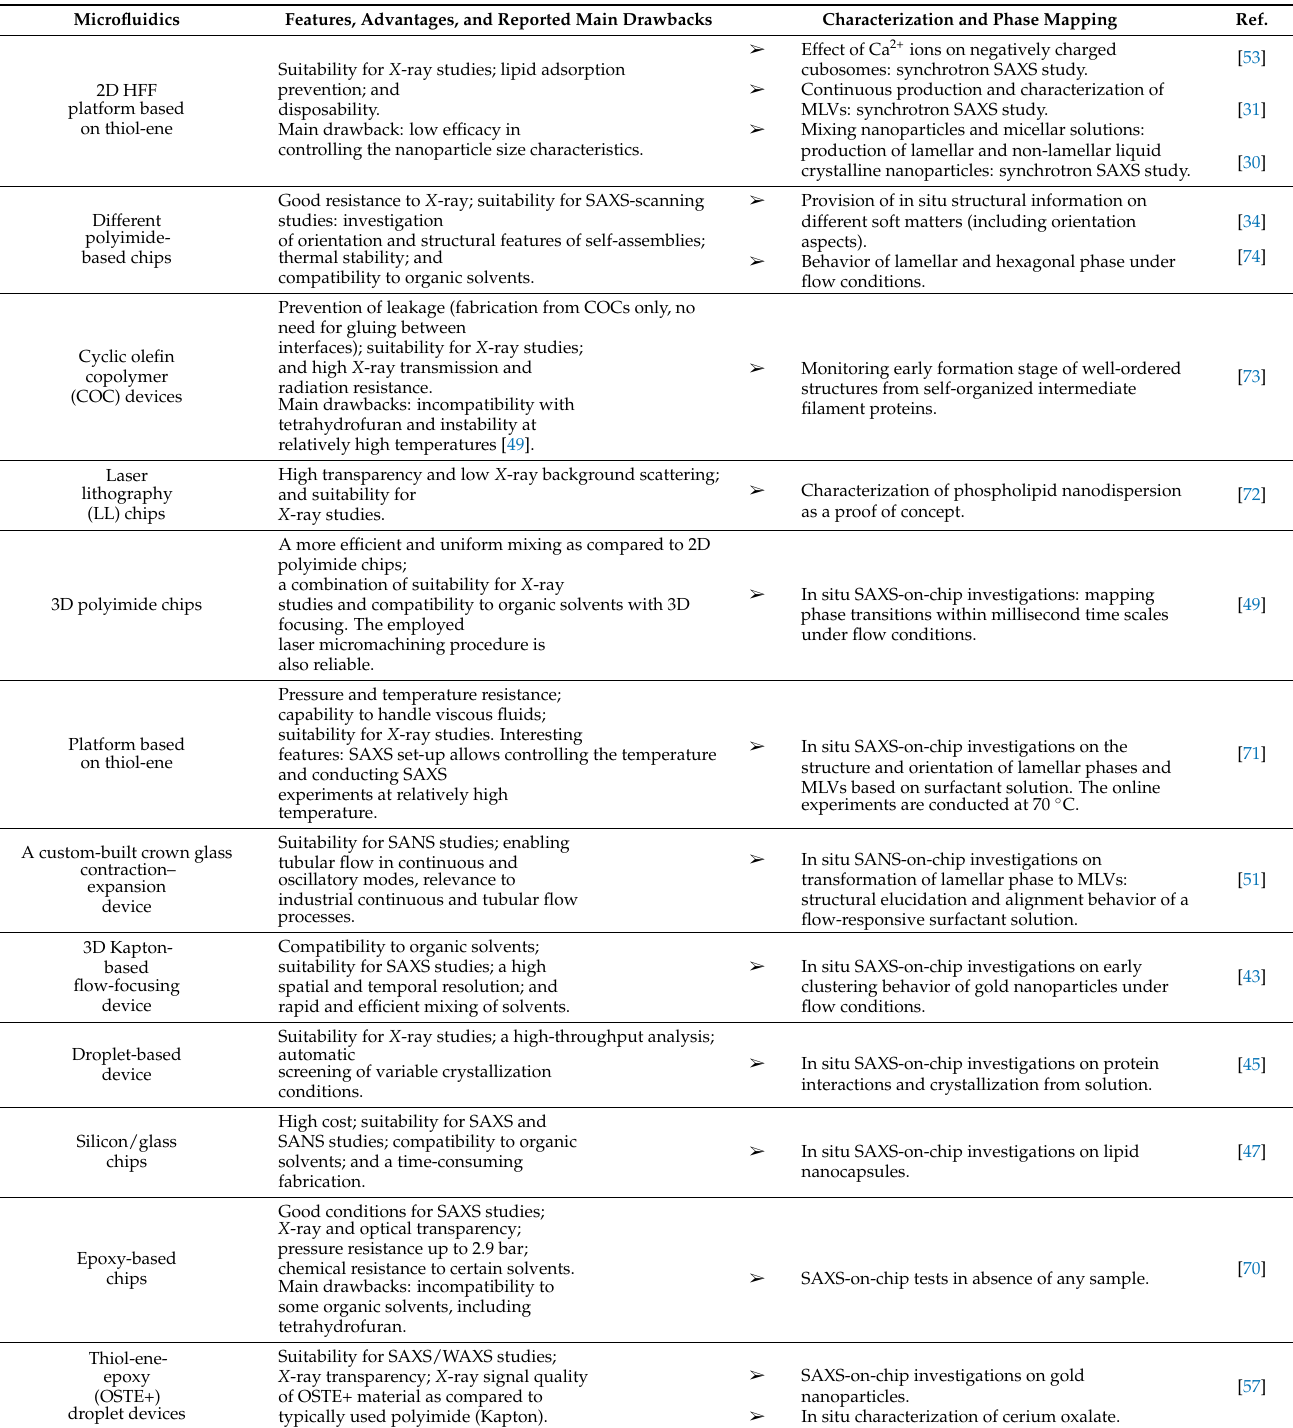
Table 1. Examples of X -ray- and neutron-compatible microfluidics and their reported uses in online structural